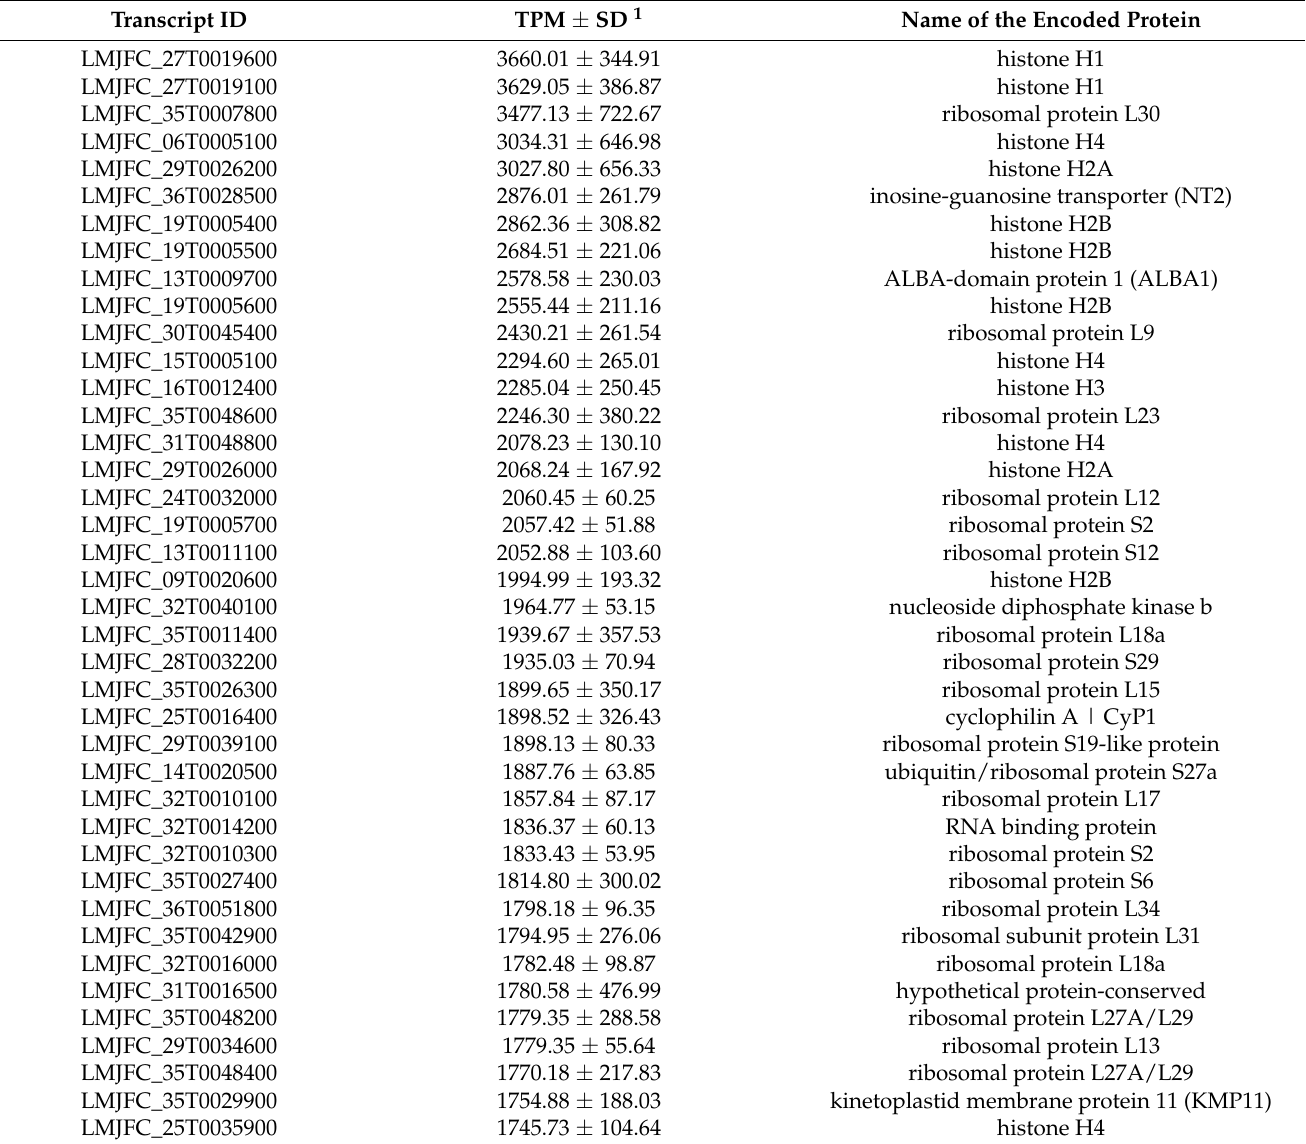
Table 3. The 40 most abundant transcripts in L. major (Friedlin strain)